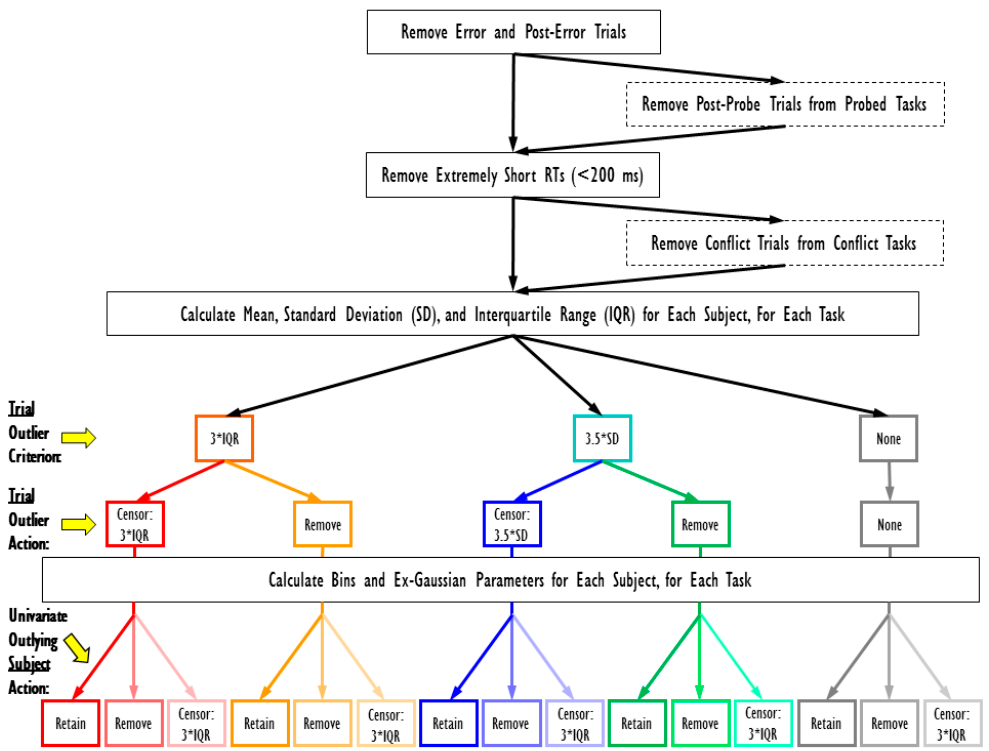
Figure 3. Mini-multiverse decision tree. Solid black boxes represent decisions that were made in every task in every multiverse iteration. Dashed black boxes include decisions that were made in some tasks (e.g., those with thought probes or conflict trials) in every multiverse iteration. Retain = kept outlier in dataset. Remove = remove outlier (trial or subject) from dataset. Censor = change outlying value to specified cuto ff